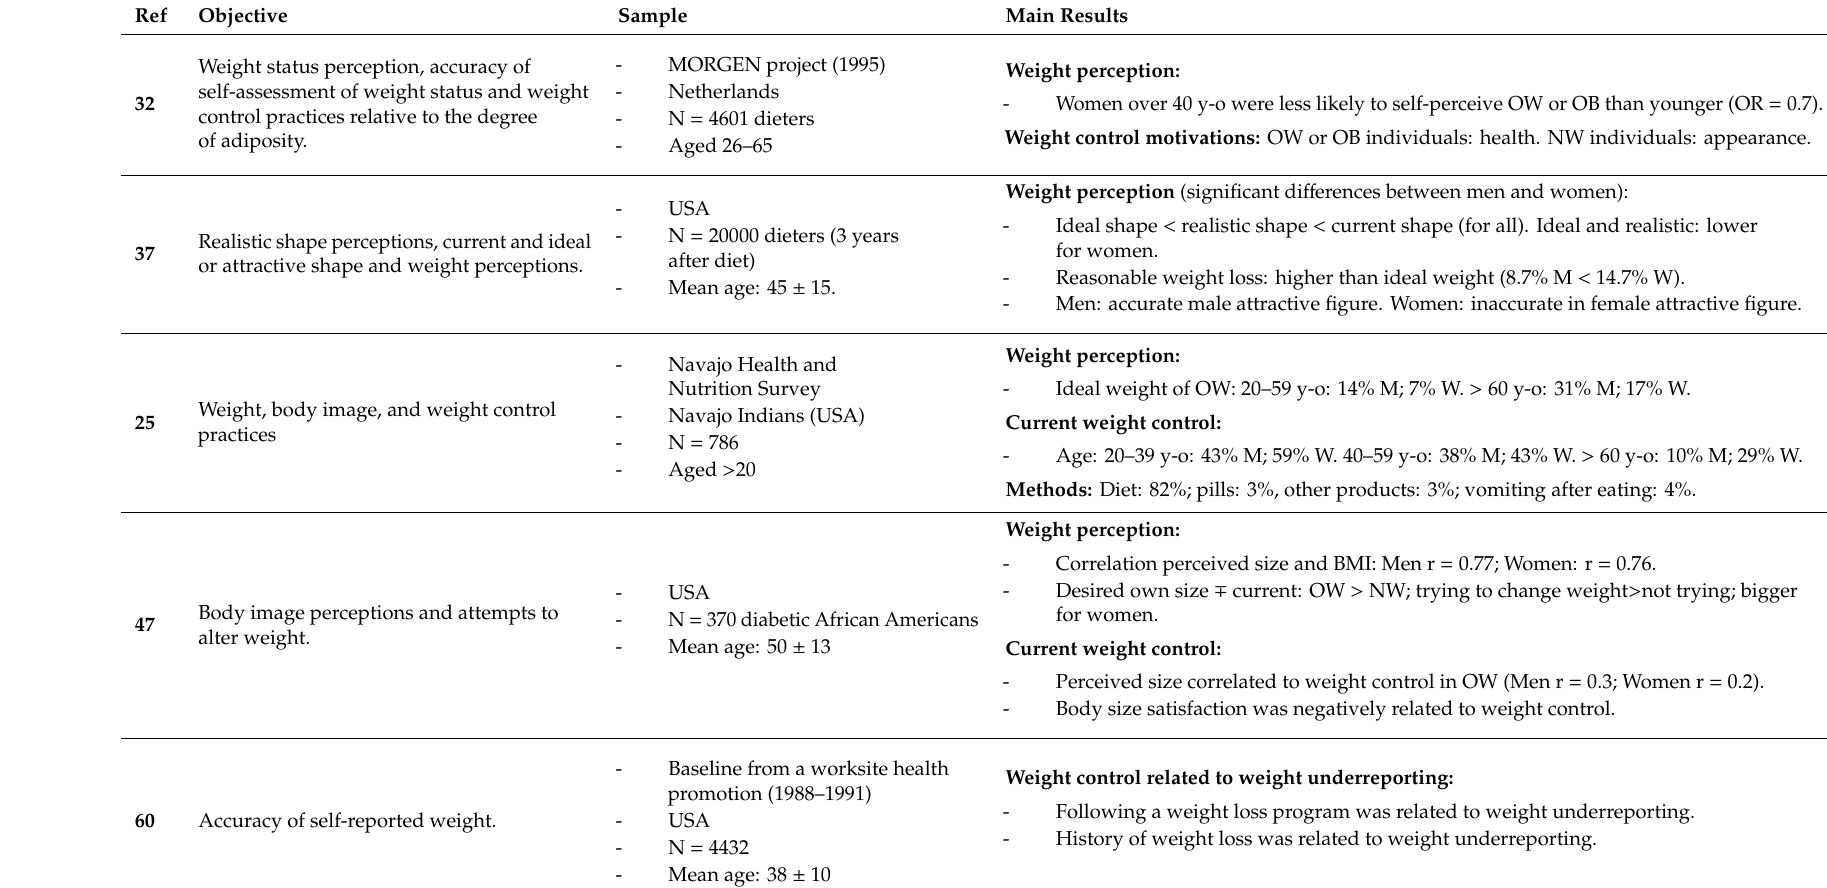
Men: accurate male attractive figure. Women: inaccurate in female attractive